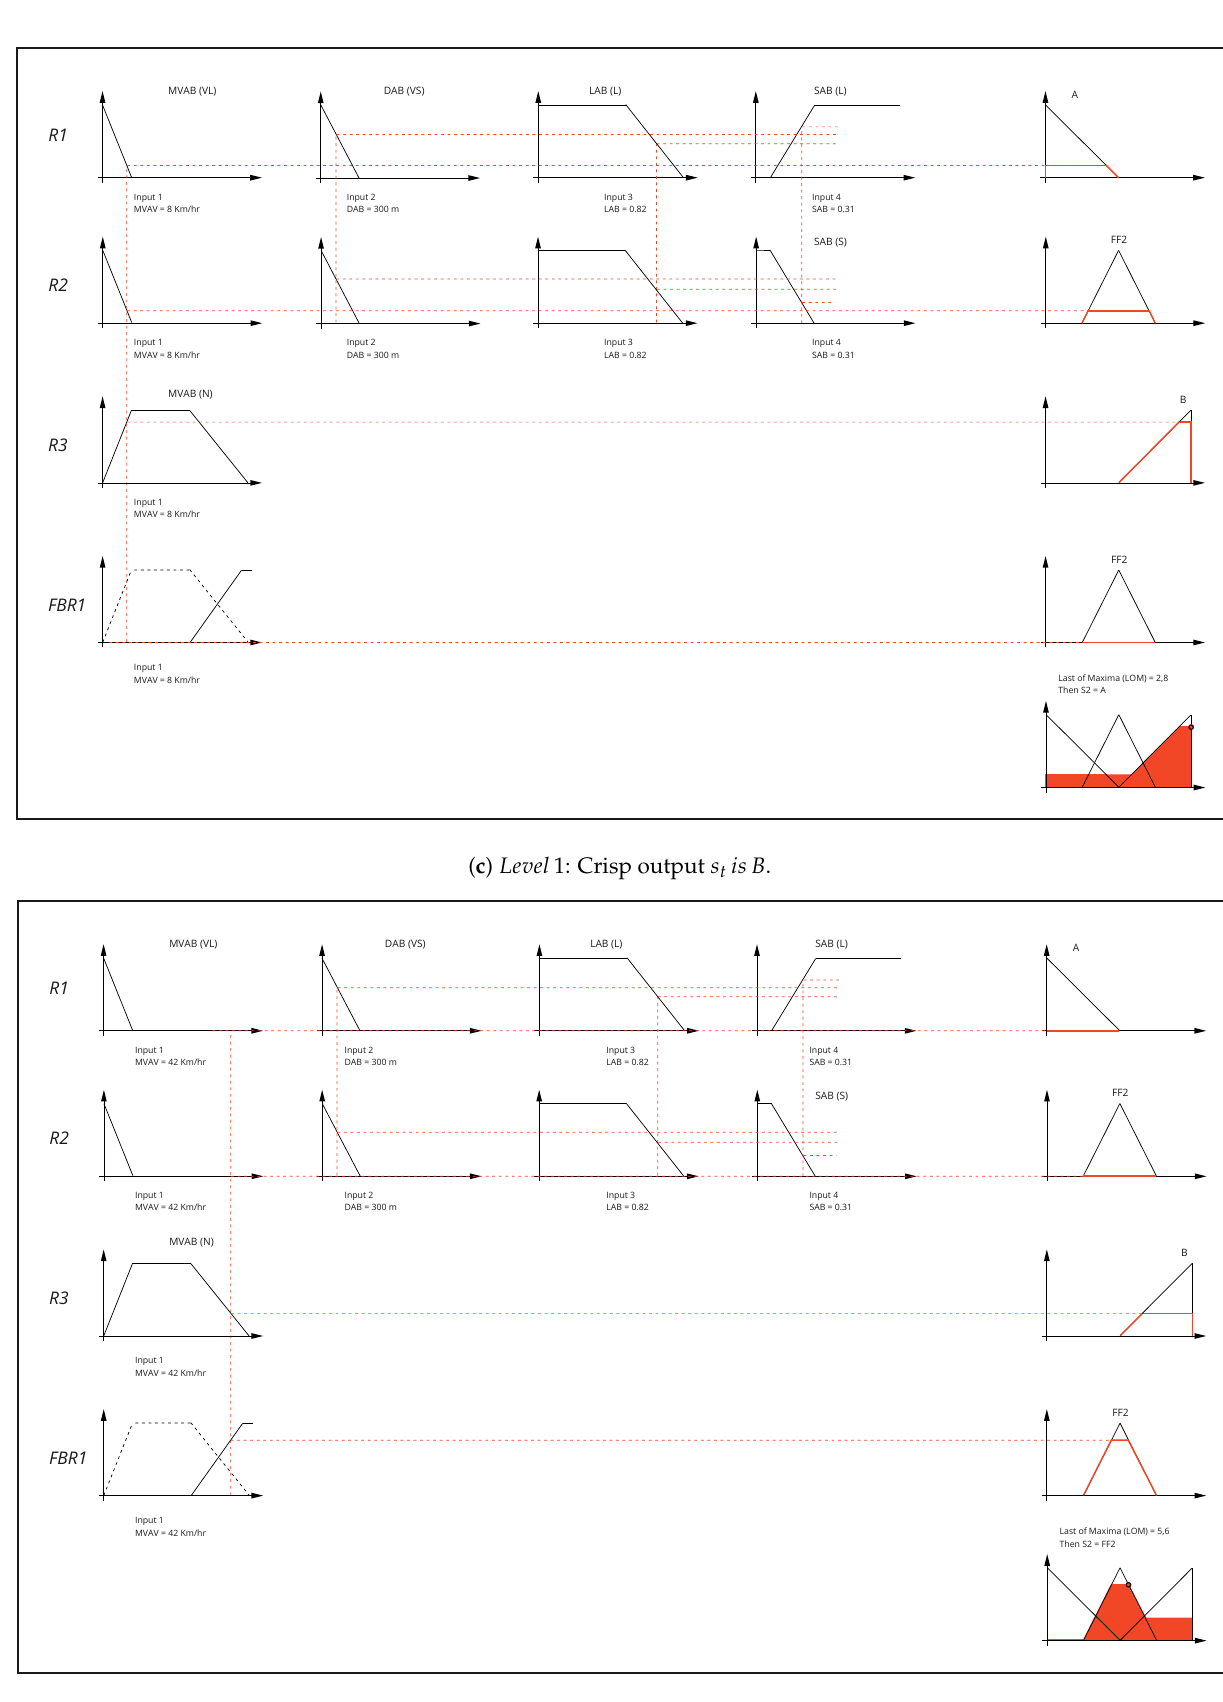
Figure 5. Levels 0 and 1 examples of hierarchy filter